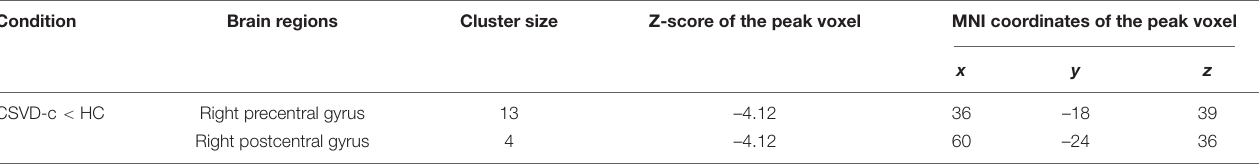
TABLE 3 | Significant differences in fALFF values among groups (ANOVA and LSD post hoc test with GRF correction, voxel-level p < 0.001, cluster-level p < 0.05). Condition